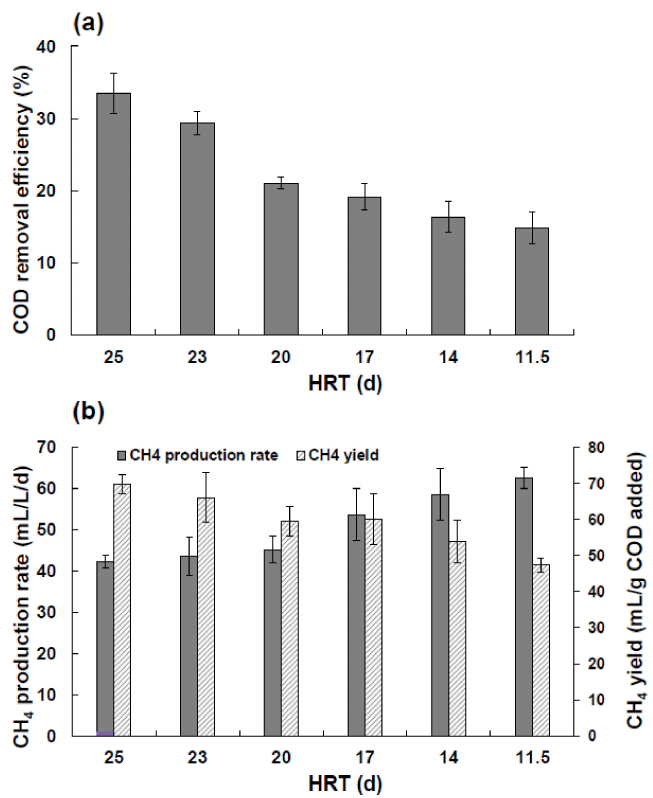
Figure 2. The COD removal efficiency ( a ) and CH4 production rate and yield ( b ) at the steady states.